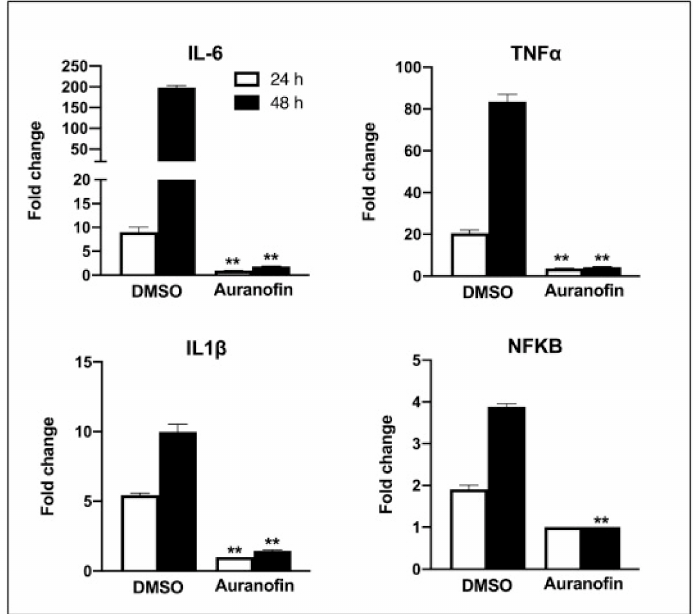
Figure 9. Auranofin therapy significantly inhibits the incidence of SARS-CoV-2-induced immune cells in living organisms: qRT-PCR was used to determine mRNA levels of IL-6, IL-1, TNF, and NF-kB at 24 and 48 h after transmission. Following correcting the GAPDH gene, the fold variation in tumor cells compared to baseline controls was determined. The data shows the mean ± SEM of two separate tests that were performed in parallel. ** p < 0.001. Reprinted/adapted with permission from Ref.